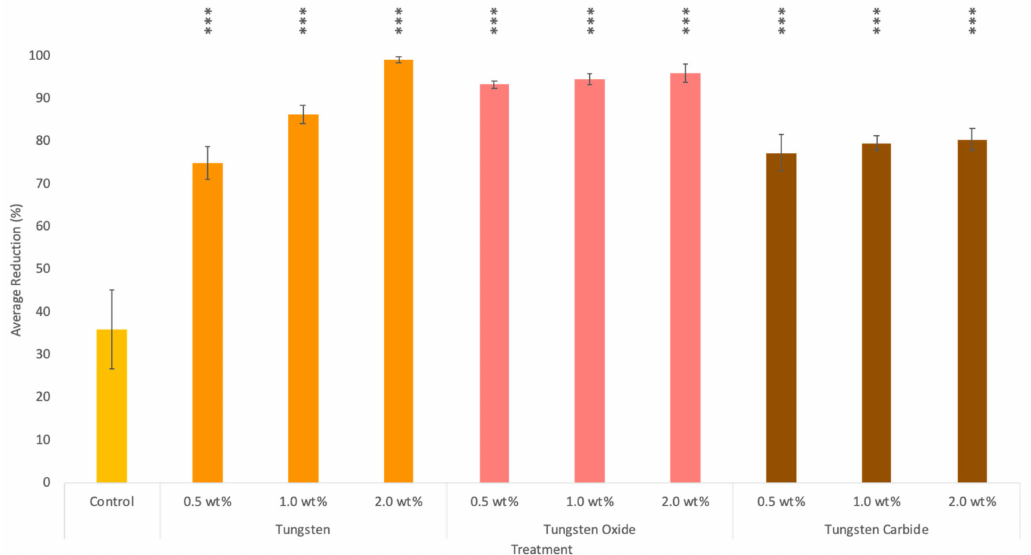
Figure 4. Graph showing the antiviral activity of tungsten, tungsten oxide and tungsten carbide at 0.5, 1.0 and 2.0 wt % against bacteriophage T4 for 24 h. Results were collected using a plaque assay, viral reductions were calculated from the number of virions present before and after exposure. Error bars represent standard deviation, n = 3. p values of < 0.001 (***) are shown on the